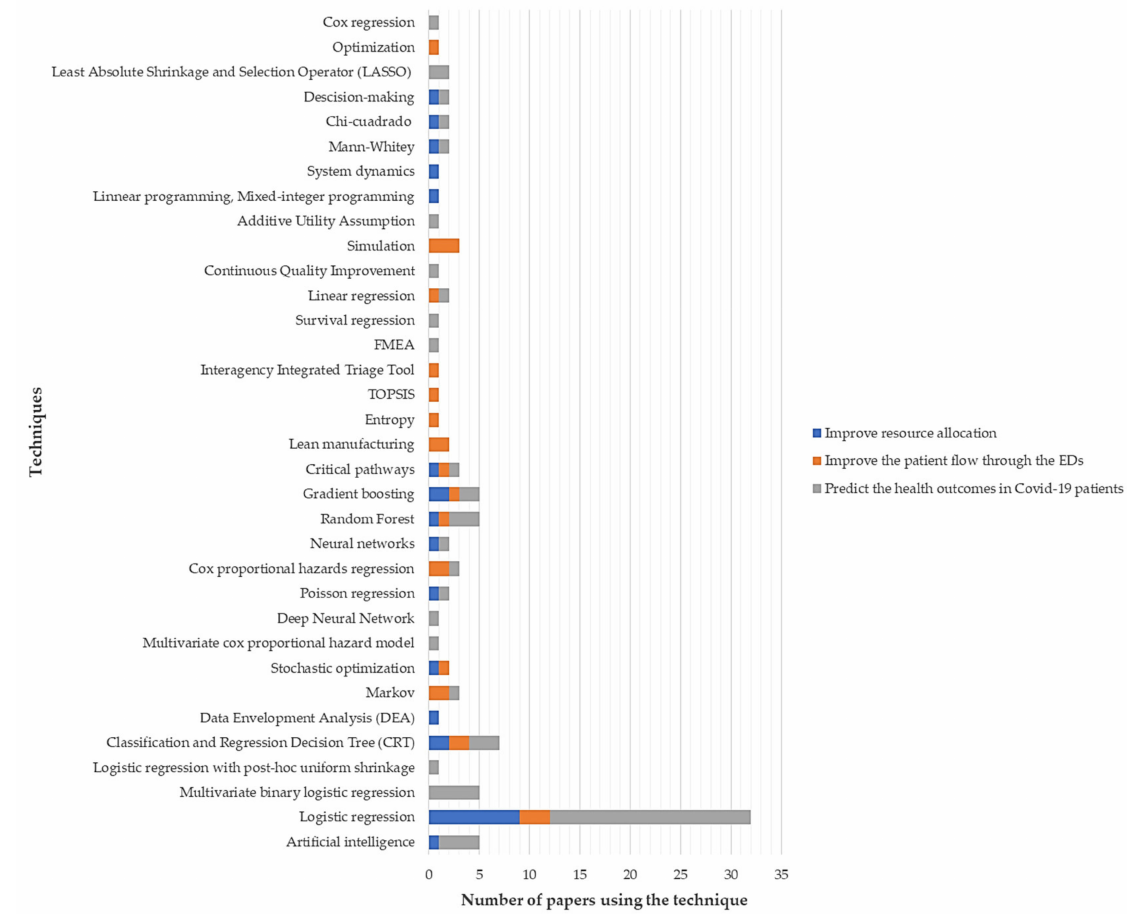
Figure 5. The techniques used to address the most popular objectives pursued by ED decision makers during the